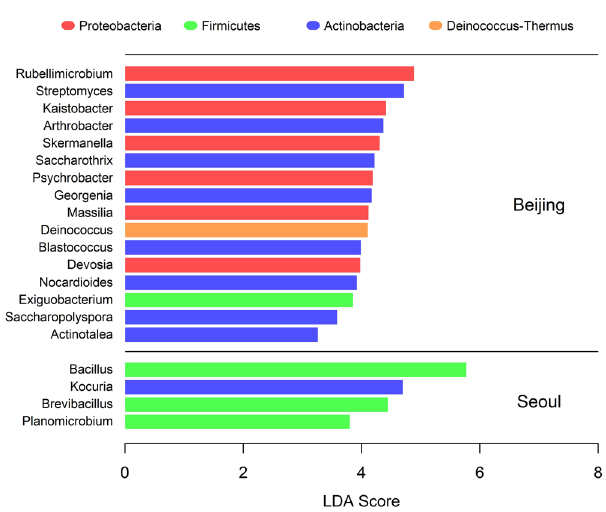
Figure 2. The results of LEfSe analysis, which identified bacterial genera that were significantly abundant in one site compared with the other two sites. Bacterial genera with the LDA score of more than 3 are shown. Colours indicate the phylum level categories of these